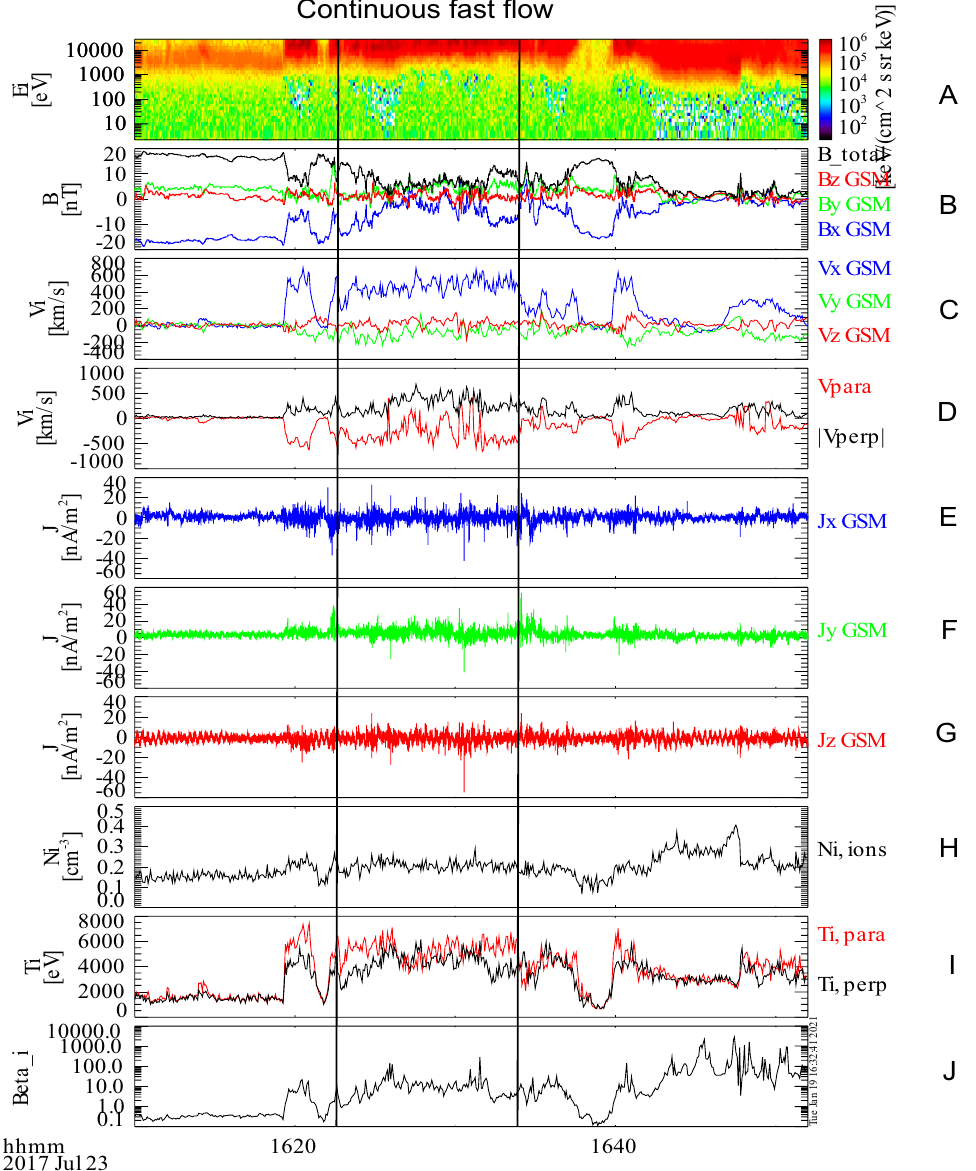
Figure 1. Continuous fast flow embedded turbulent current sheet on 23 July, 2017 by MMS1 spacecraft (GSM coordinates). ( A ) plots ion energy spectrum. ( B ) shows measured Bx, By, Bz, and B total. ( C ) is measured Vx, Vy, and Vz. ( D ) is parallel velocity (V // ) and perpendicular velocity (V ⊥ ). ( E – J ) are the three components of the current density (calculated by J = ∇ × B ∕ μ 0 ). ( H , J ) show ion density (n) and temperature (T). Panel J is plasma β (ratio of thermal pressure to magnetic